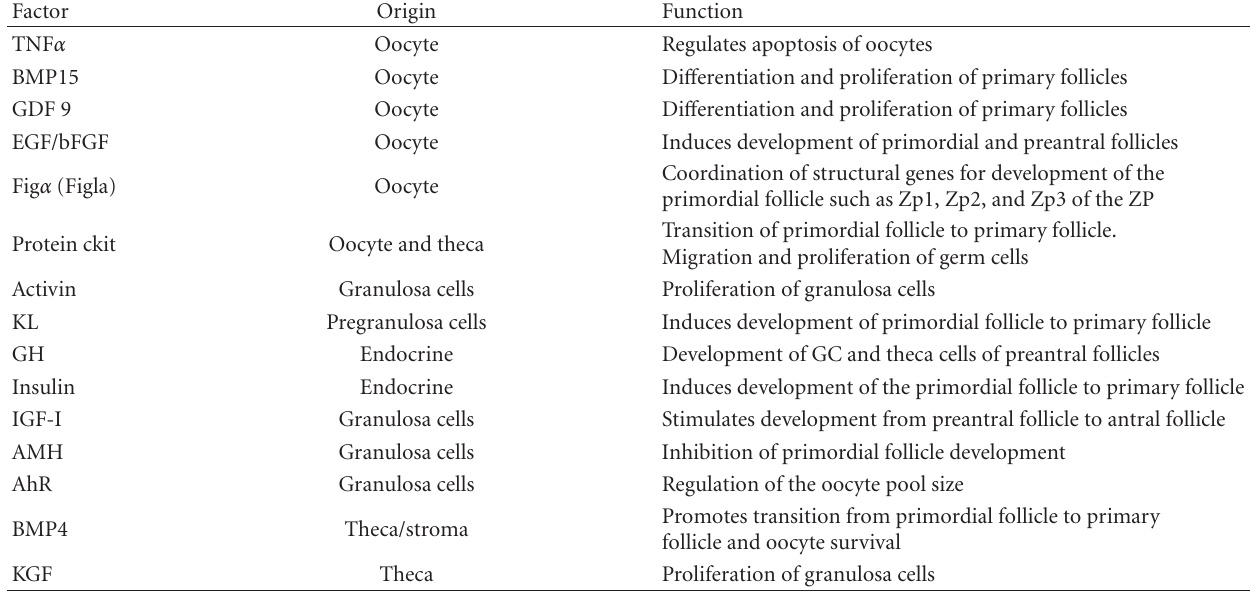
Table 3: Factors that can promote growth and development of preantral follicles [2,